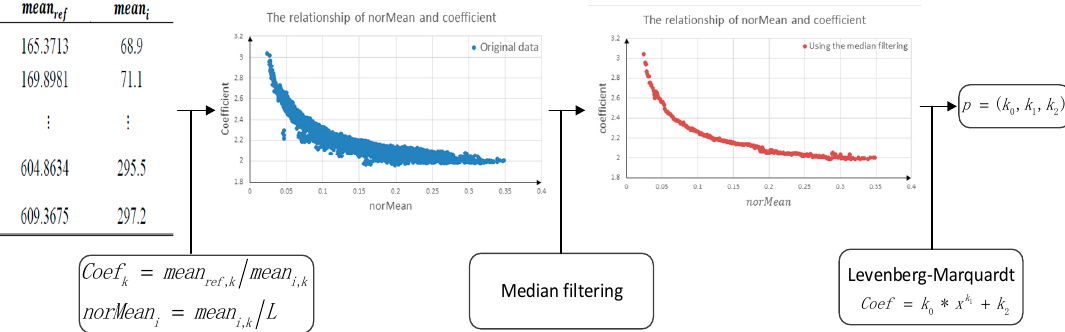
Figure 8. Obtain the coefficients based on the power-law model.